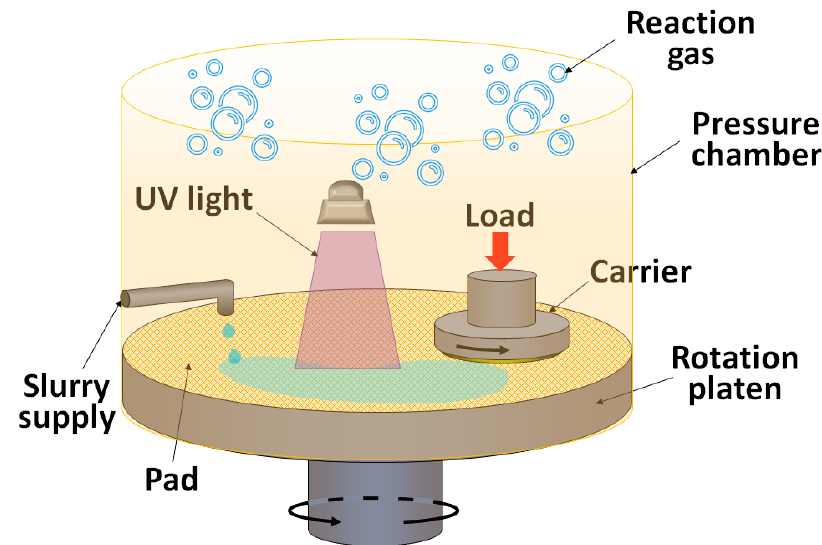
Figure 8. Typical setup for SiC gas-PCMP.